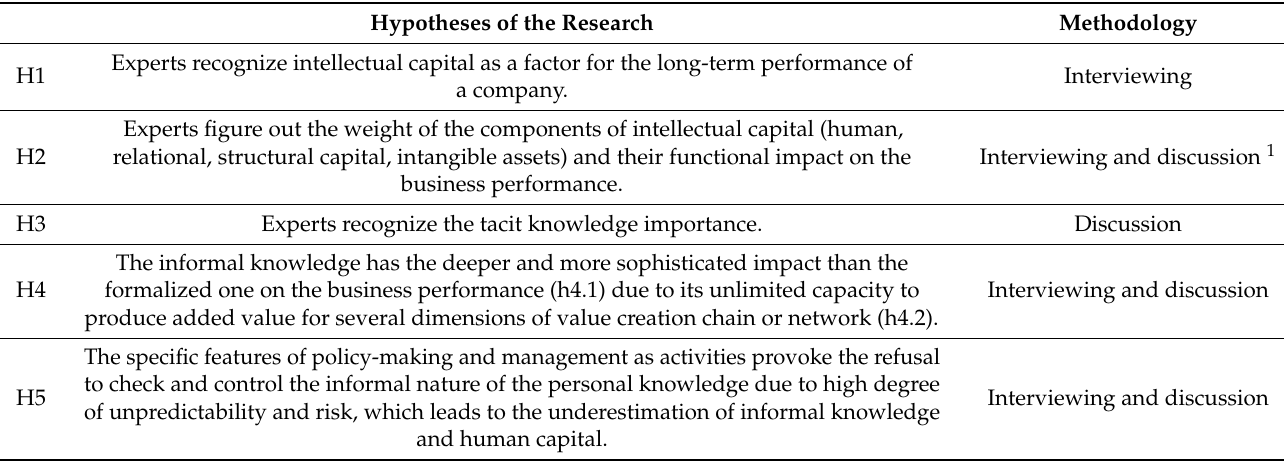
Table 2. Methods used for checking the research